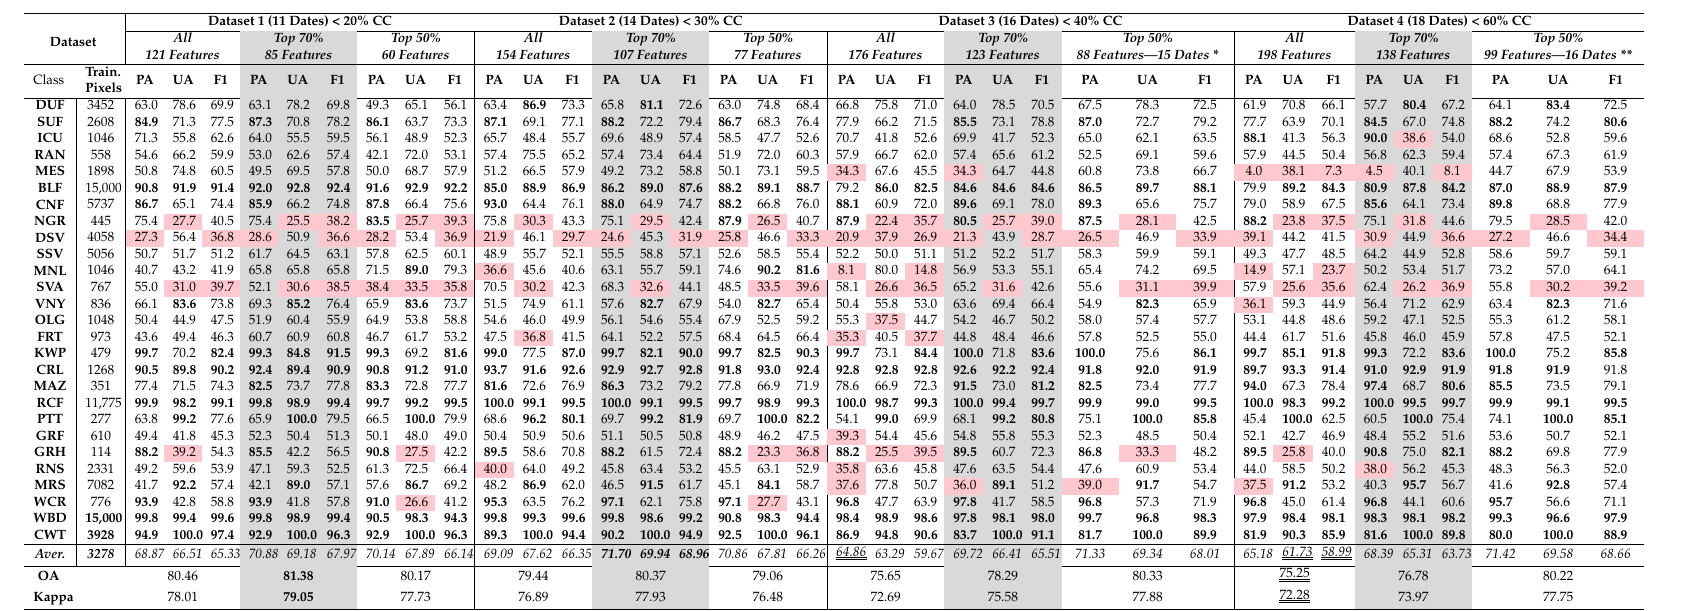
Table 6. Validation metrics (%) for experiments performed: PA, UA and F1 rates are presented per class, while their average rates, the OA and the kappa metric are displayed in the last three rows per experiment. Per-class accuracy rates below 40% are coloured red while those over 80% are marked with bold. The overall highest Average (Aver.), OA and Kappa rates (last three rows) are marked bold, while the lowest ones are double underlined.